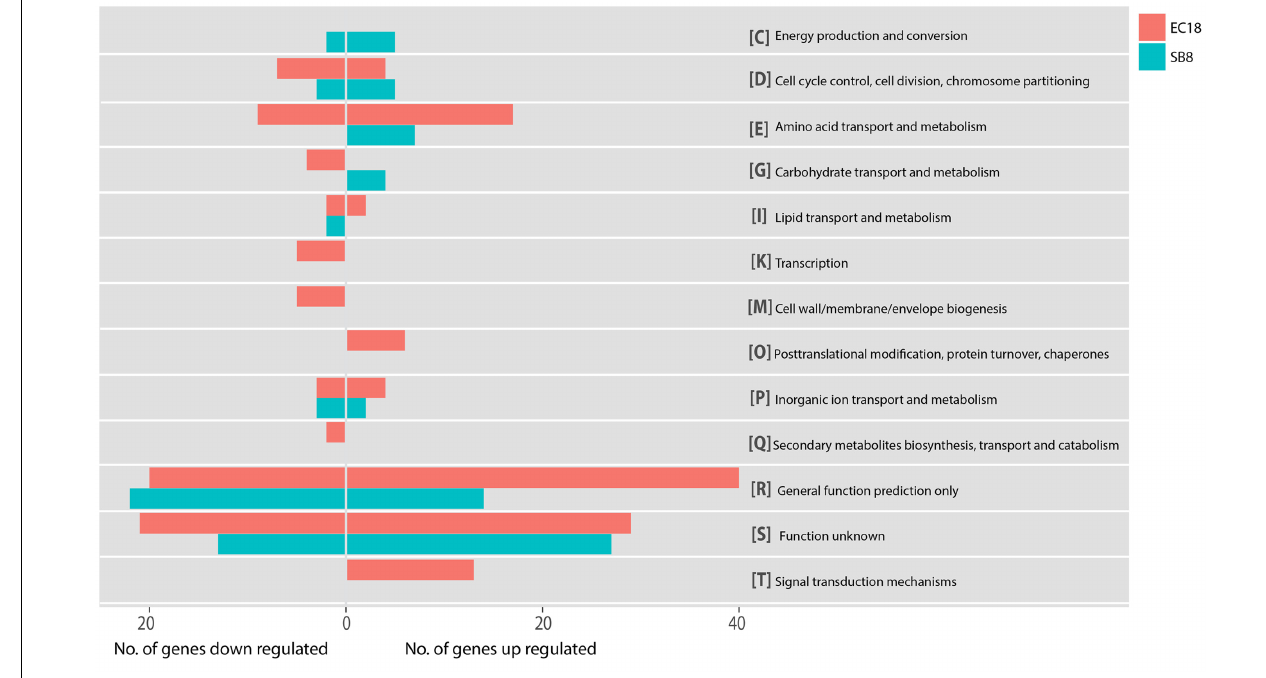
FIGURE 4 | Functional categories of genes regulated of strain EC18 and SB8 according to COGs (Clusters of Orthologous Groups). Categorization of all altered genes was done on the Genome2D server (http://genome2d.molgenrug.nl).